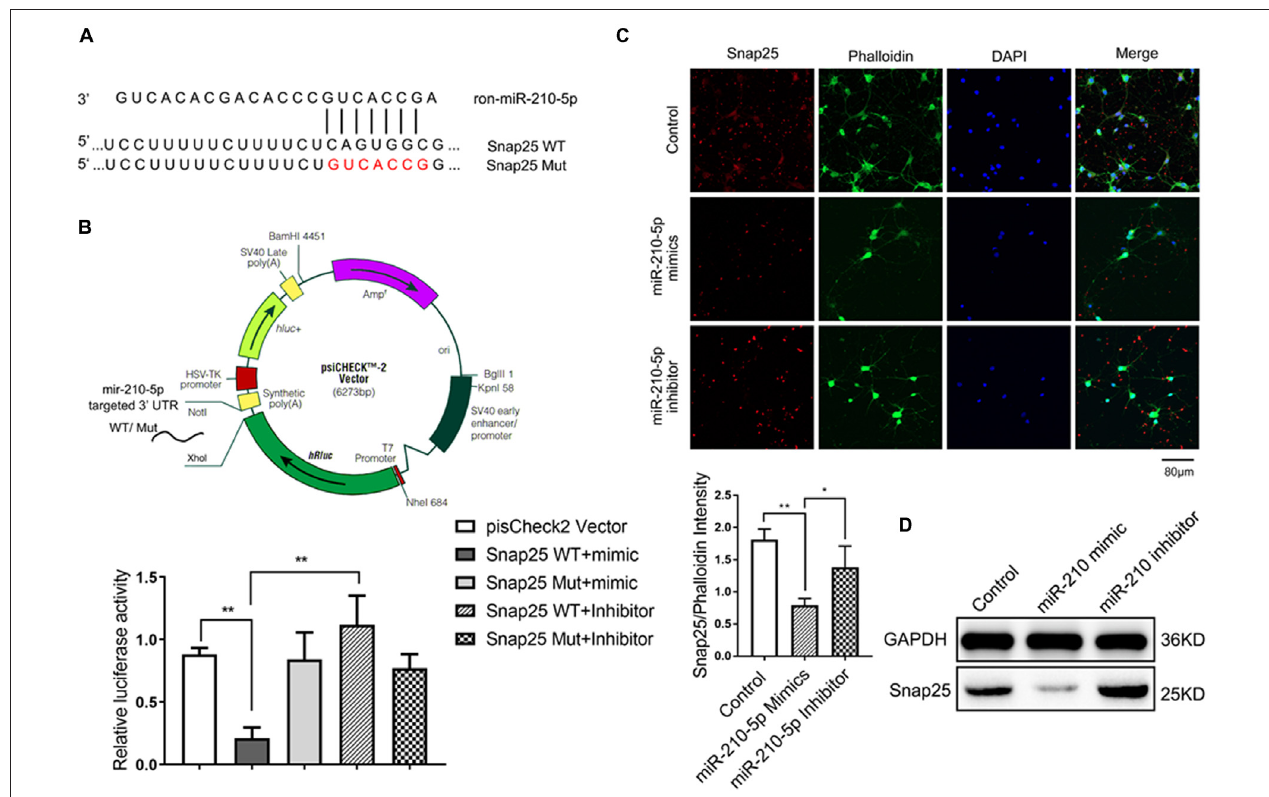
FIGURE 5 | miR-210 can specifically target on synaptosomal-associated protein of 25KDa (Snap25; n = 3/group, 2 images per sample). (A) The target sites of miR-210-5p in Snap25 mRNA 3’ untranslated region (3’UTR) were analyzed by Targetscan 7.0. (B) The construction profile of psiCHECK2-Snap25 wild-type (WT) and Mut vectors are shown above. Snap25 luciferase reporter (Snap25 3’ UTR WT) and the corresponding mutant construct (Snap25 3’ UTR Mut) were co-transfected into PC12 cells together with miR-210 mimics and inhibitor respectively. Luciferase activity was measured 24 h post transfection. Values are expressed relatively to the internal firefly luciferase activity. (C) Immunofluorescence and its intensity analysis showed miR-210-5p mimics decreased Snap25 protein expression in Primary neuron cells, whereas miR-210-5p inhibitor increased snap 25 protein expression. (D) Western blot results showed a decrease of Snap25 protein expression in primary neuron cells treated with miR-210-5p mimics, whereas they showed an increase of snap 25 expression in cells with miR-210-5p inhibitor. Data are shown as mean ± SD values, and statistical significance between both groups is defined as ∗ P < 0.05; ∗∗ p <